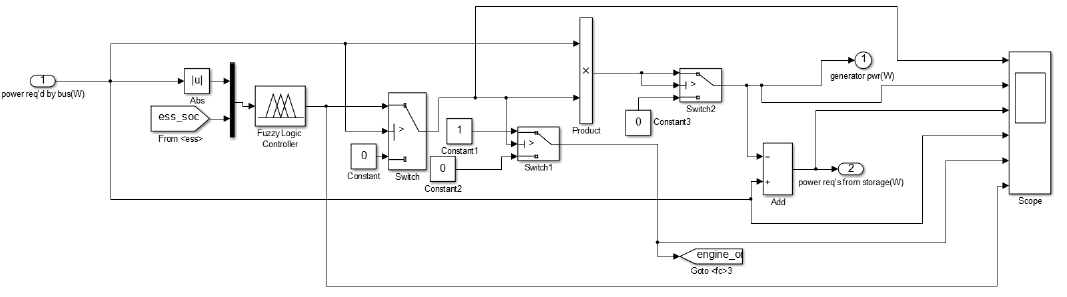
Figure 2. Proposed fuzzy logic control.